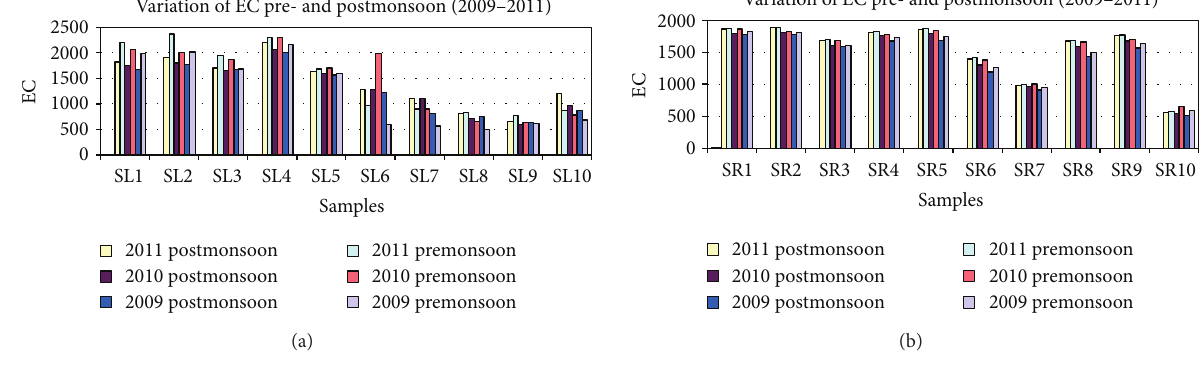
value of BOD was 6.8995 ± 1.34 mg/L and 6.755 ± 1.27 mg/L during the pre- and postmonsoons which shows the presence of soluble salts in the sampling sites. The maximum variance value during the premonsoon of CV% = 20.38 was found to be higher than the postmonsoon seasons CV% =